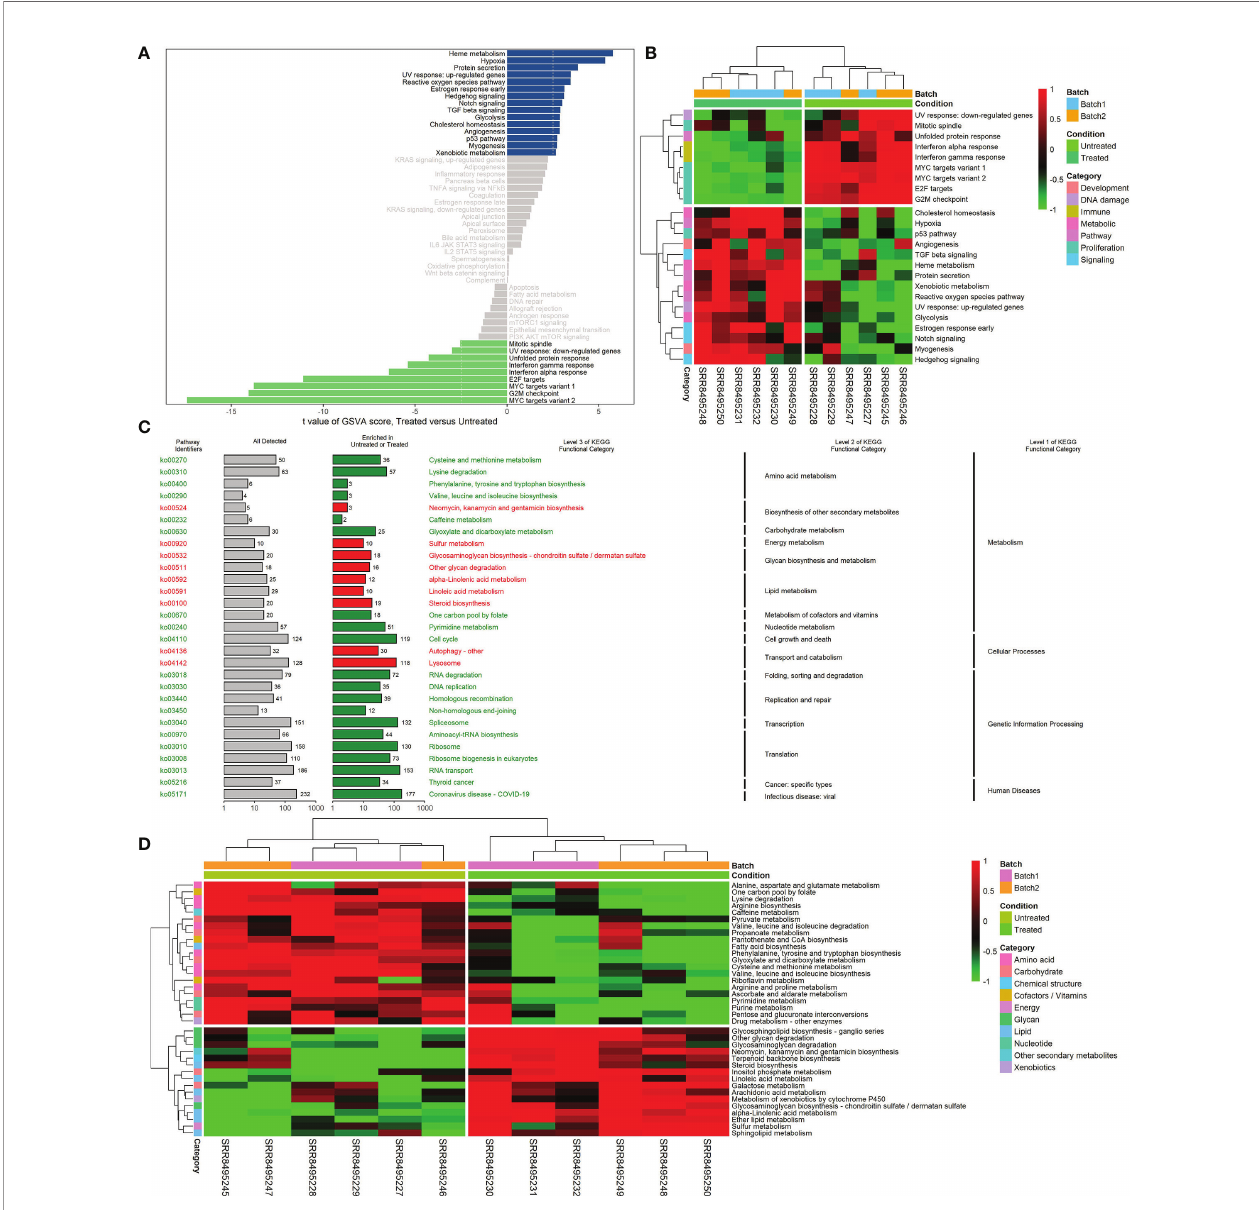
FIGURE 3 | Differences in hallmark or KEGG pathway activities scored per sample by GSVA between CKI-treated and control groups. (A) Differential hallmark pathway activities in CKI-treated versus control groups. (B) Clustering results of hallmark pathway activities between CKI-treated and control groups. The heatmap visualizes differential hallmark gene sets (adjusted P < 0.05). (C) Signi fi cantly different KEGG functional categories and pathways between CKI-treated and control groups. The pathways with |log 2 FC| > 0.5 and adjusted P < 0.05 are visualized. KEGG functional categories and pathways that were signi fi cantly enriched in the CKI-treated group are shown in red; those signi fi cantly enriched in the control group are shown in green. (D) Clustering results of KEGG metabolic pathway activities between CKI-treated and control groups. The heatmap visualizes differential KEGG metabolic pathway (adjusted P <